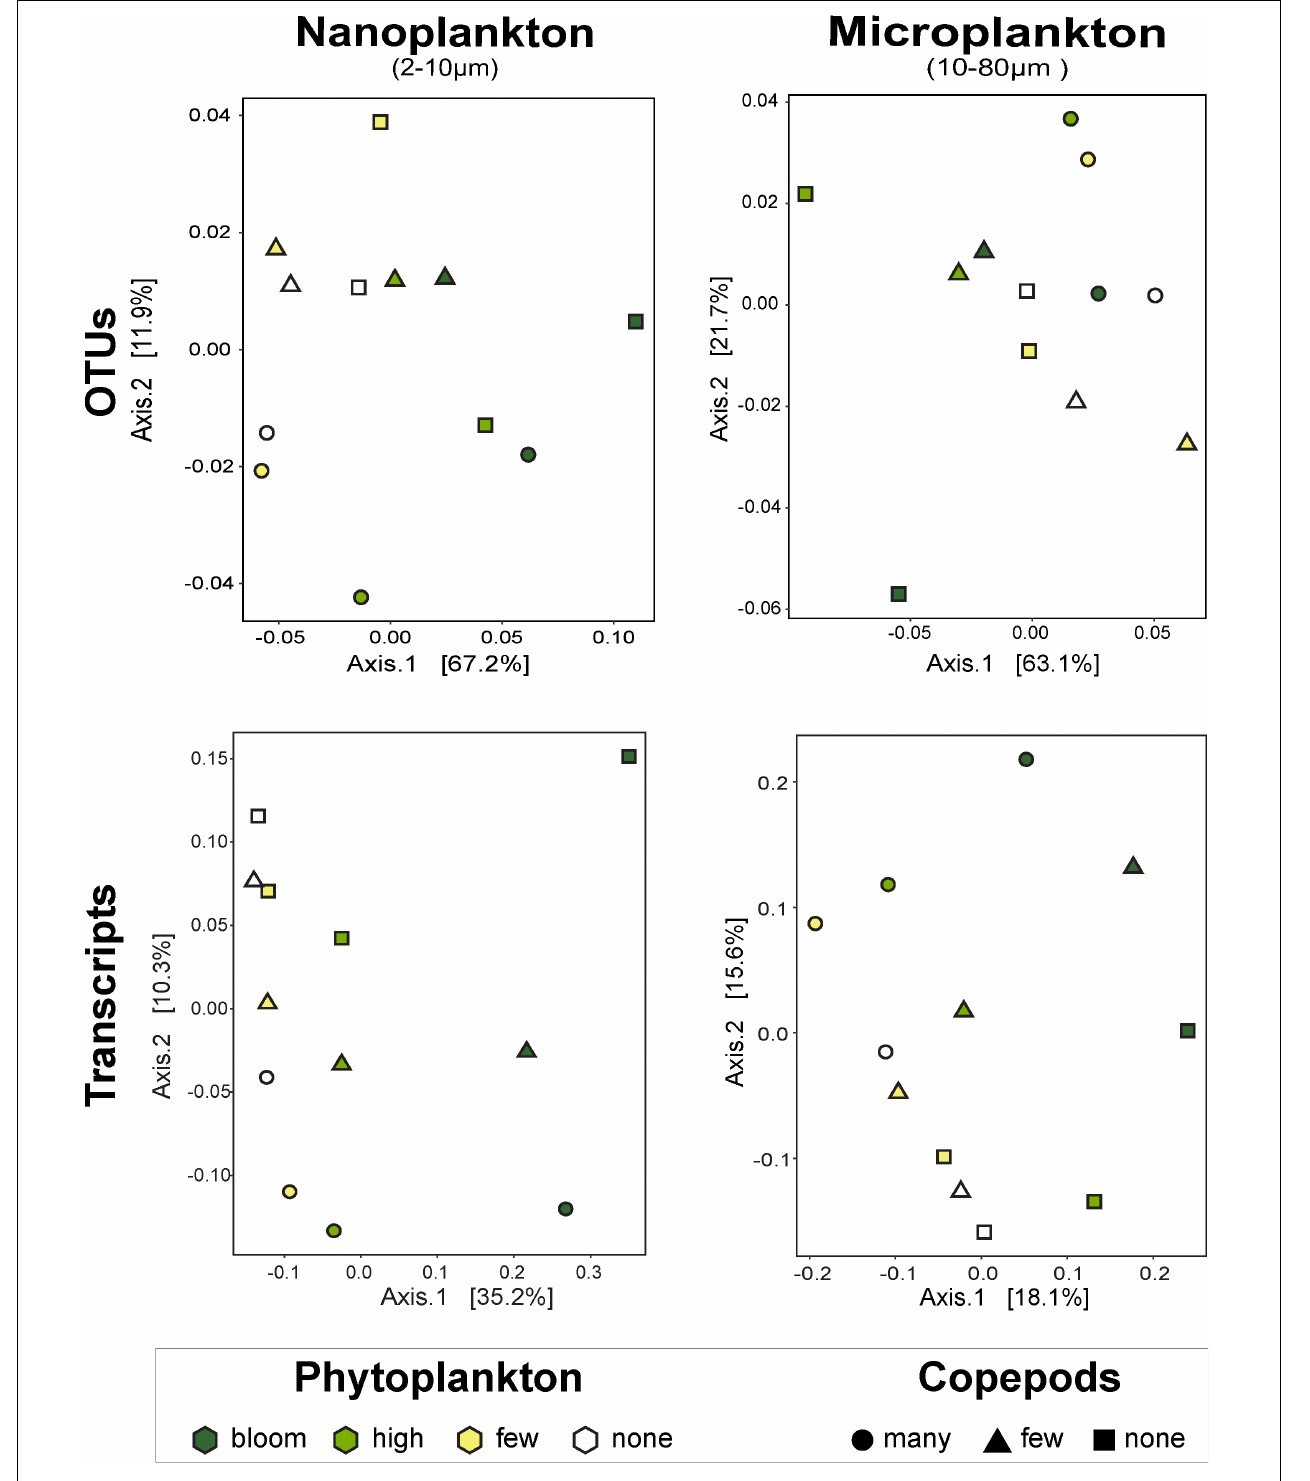
FIGURE 3 | Principal coordinates analysis by size fractions of the impact of phytoplankton and copepods abundance on community composition (i.e., OTUs) and on function (i.e., transcripts). The nanophytoplankton added had the strongest impact on nanosized community. Except for the microsize community composition, there is a clear response to the added phytoplankton, notably at high and bloom abundance. The addition of predators did not show a clear trend. UniFrac dissimilarity index was used for the OTUs and the Canberra dissimilarity index for the metatranscriptome data. The percentages on the axes represent the variability represented by each